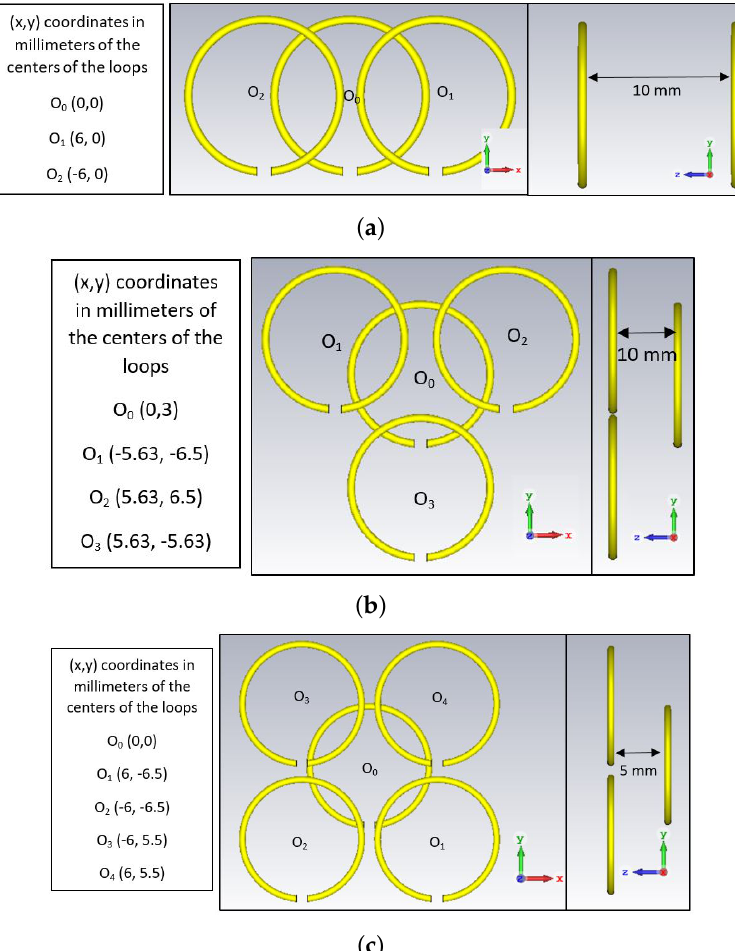
Figure 5. WPT links analyzed through full-wave simulations. ( a ) Case 1: single transmitter and two-receiver link; ( b ) Case 2: single transmitter and three–receiver link; ( c ) Case 3: single transmitter and four-receiver link. In all cases the transmitter is the loop with the center in the point O 0